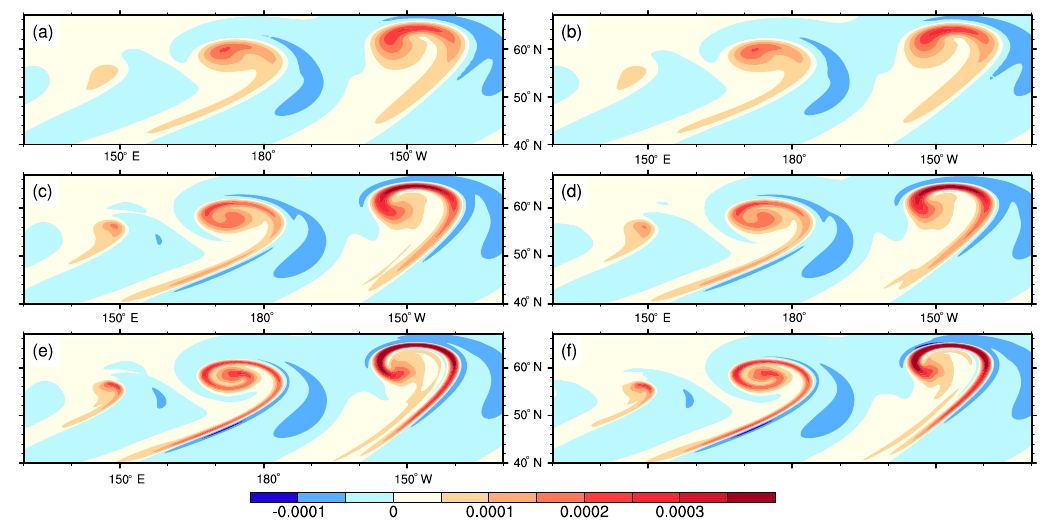
Figure 4. The same as Fig. 3, but lat–lon grids with variable resolution in latitude (no reduction) in the left